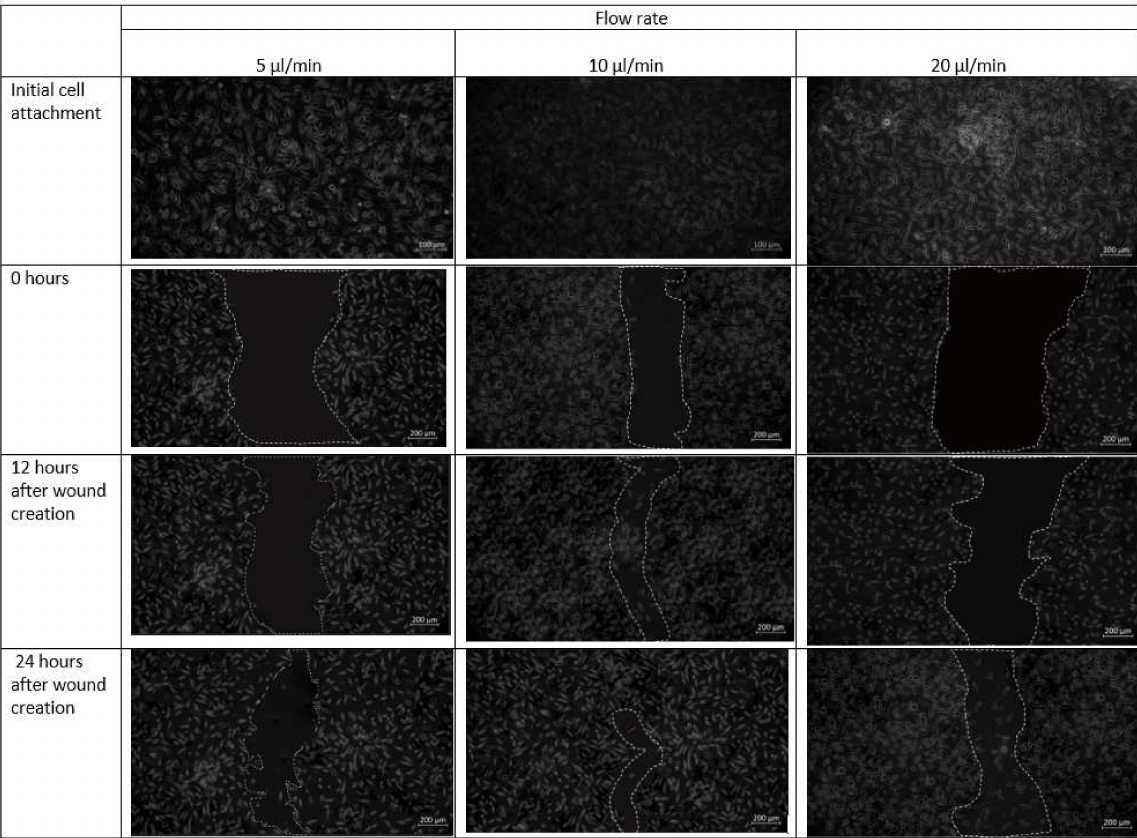
Figure 11. Micrographs of the wound-healing process of design 1 under a flow rate of 5 µ L/min, 10 µ L/min and 20 µ L/min. Images are captured using bright field microscope (ZEISS Axio Vert.A1). Image analysis was performed using ImageJ software. Scale bar 200 µ